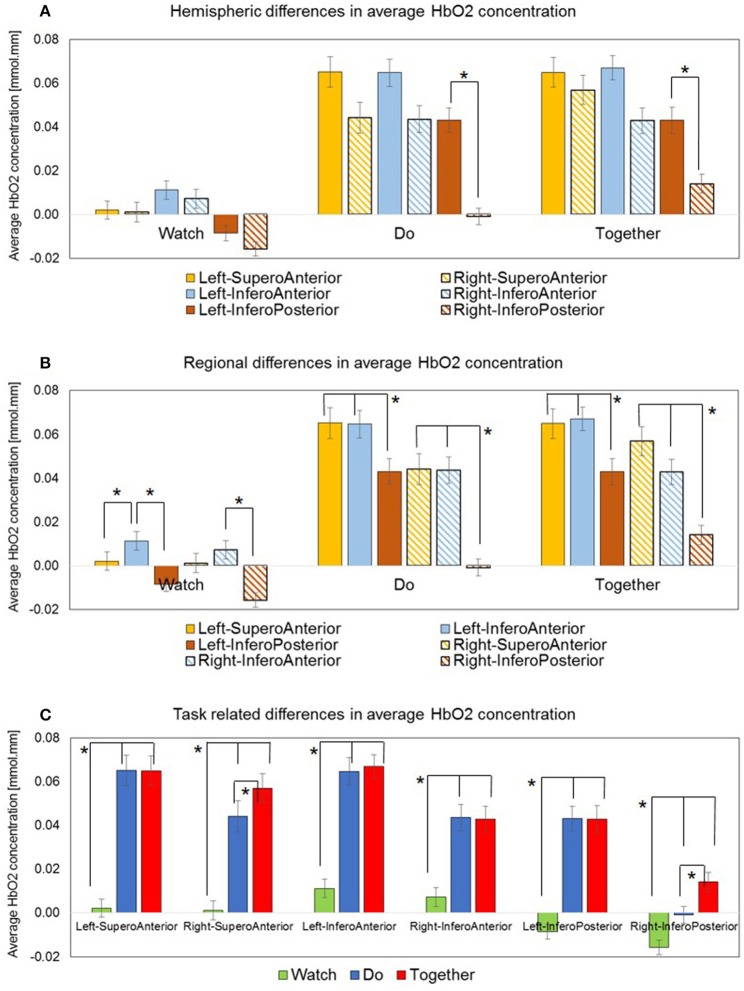
Average HbO2 concentration data is plotted in three ways: (A) Hemispheric differences: Only Left IP > Right IP. (B) Regional differences: Left IA > IP, Right IA > IP, Left IA > SA and a similar trend for Right IA > SA. (C) Task-related differences: Do and Together > Watch, for all ROIs. Together > Do for two ROIs, Right SA, and Right IP. *Indicate significant differences.